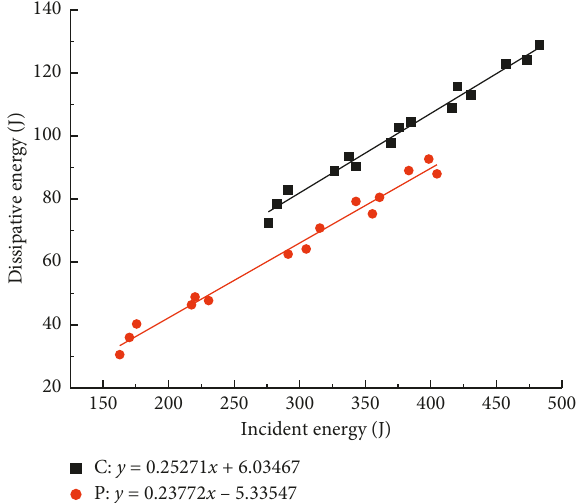
Figure 6: Relationship between dissipative and incident energies when parallel (P) and vertical (C) beddings were loaded.